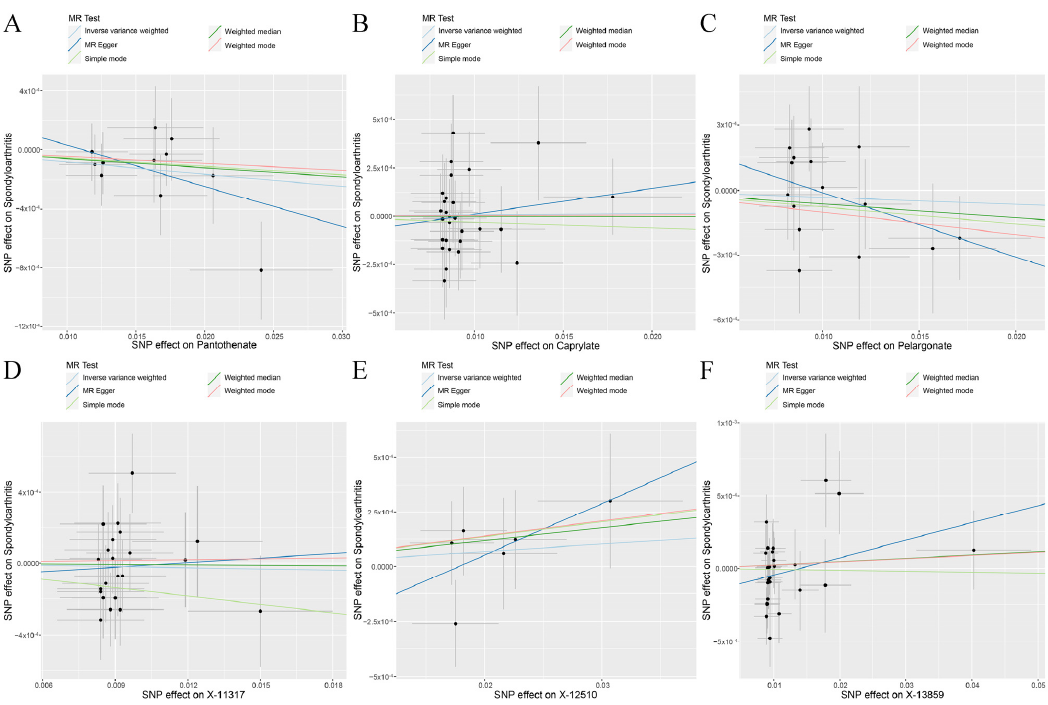
Figure 3. MR analysis results of the X-10395 and spondyloarthritis. ( A ) Scatter plot; ( B ) leave-one- out analysis.